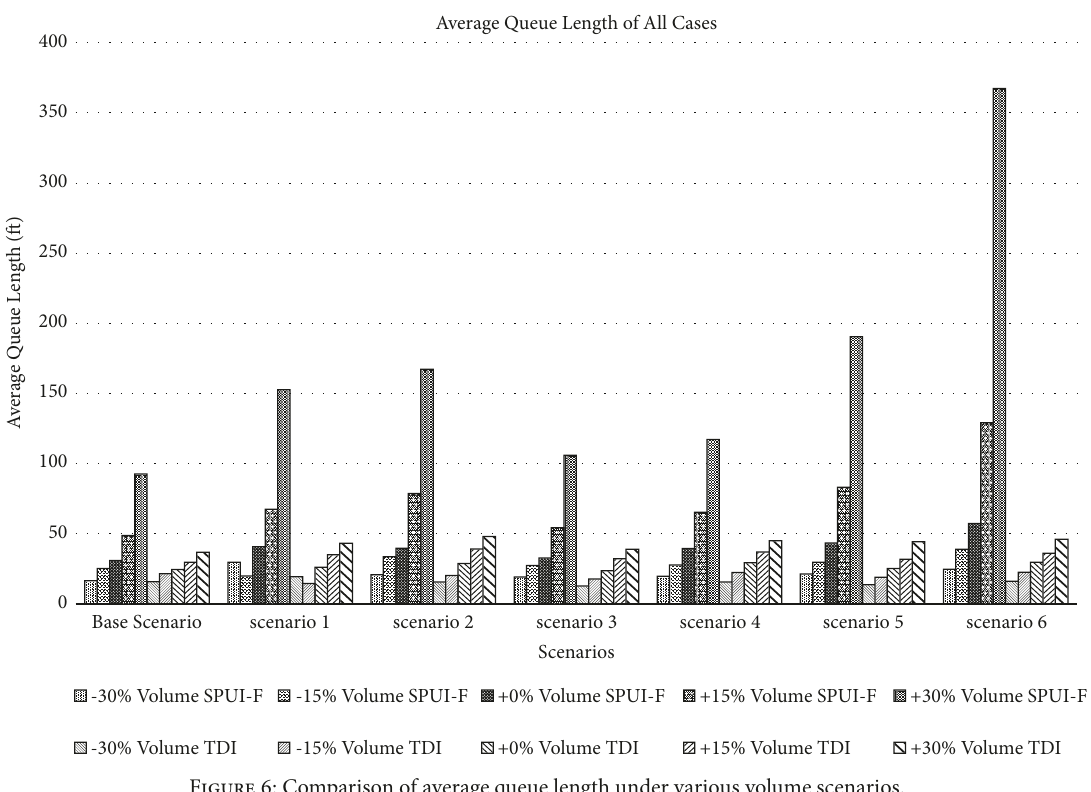
Figure 6: Comparison of average queue length under various volume scenarios.